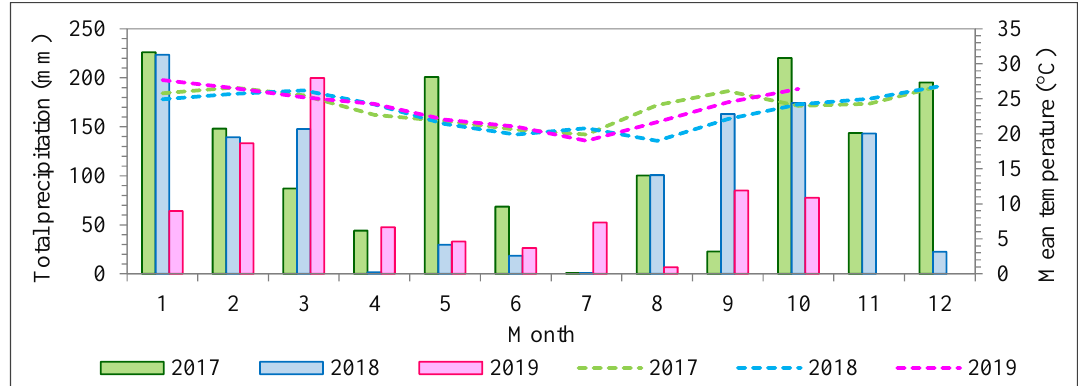
Figure 2. Climograph of Paranapoema station from the National Institute of Meteorology. Bars represent the accumulated rainfall per month (mm), and dashed lines represent the mean monthly temperature (°C).